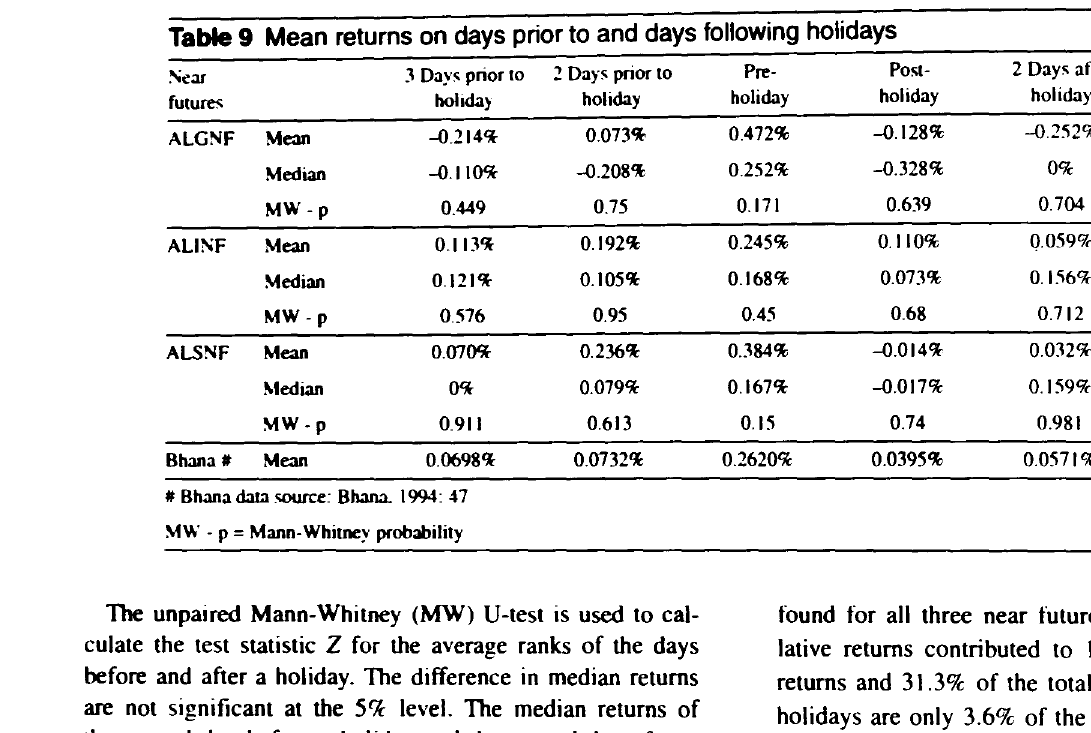
Table g Mean returns on days prior to and days following holidays